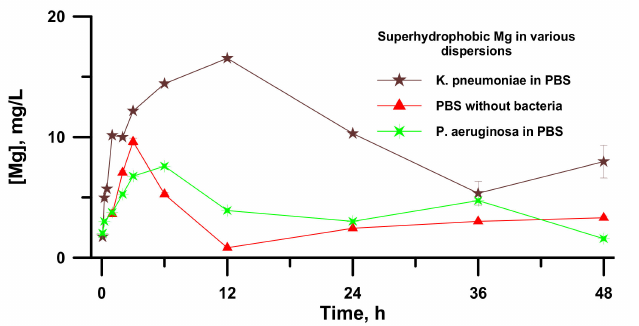
Figure 5. Time evolution of the magnesium content in PBS-based bacterial dispersions contacted with a superhydrophobic MA8 sample. Error bars represent the standard